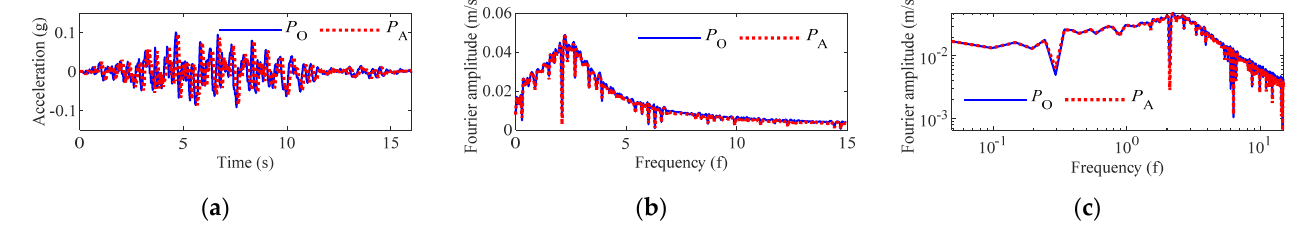
Figure 9. ( a ) Simulated accelerations. ( b ) Fourier spectra of the simulated accelerations. ( c ) Fourier spectra of the accelerations on a log–log scale.